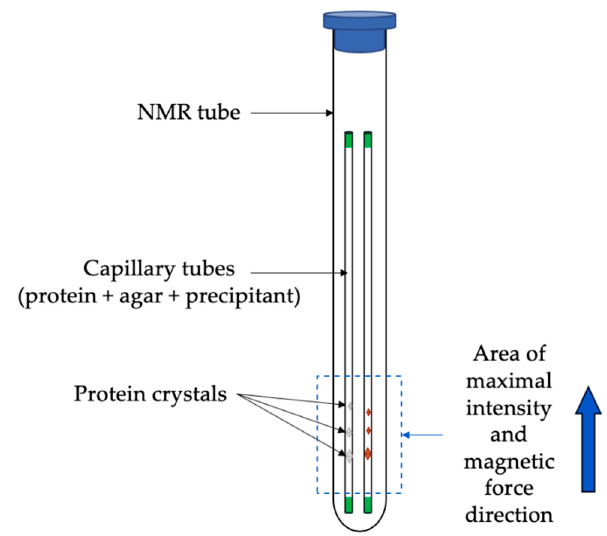
Figure 12. NMR tube setup for the capillary pipettes containing the protein solutions for crystal growth. This tube will be inserted into de magnet for the entirety of the experiment with the breathing pulses programming (described in the text below).